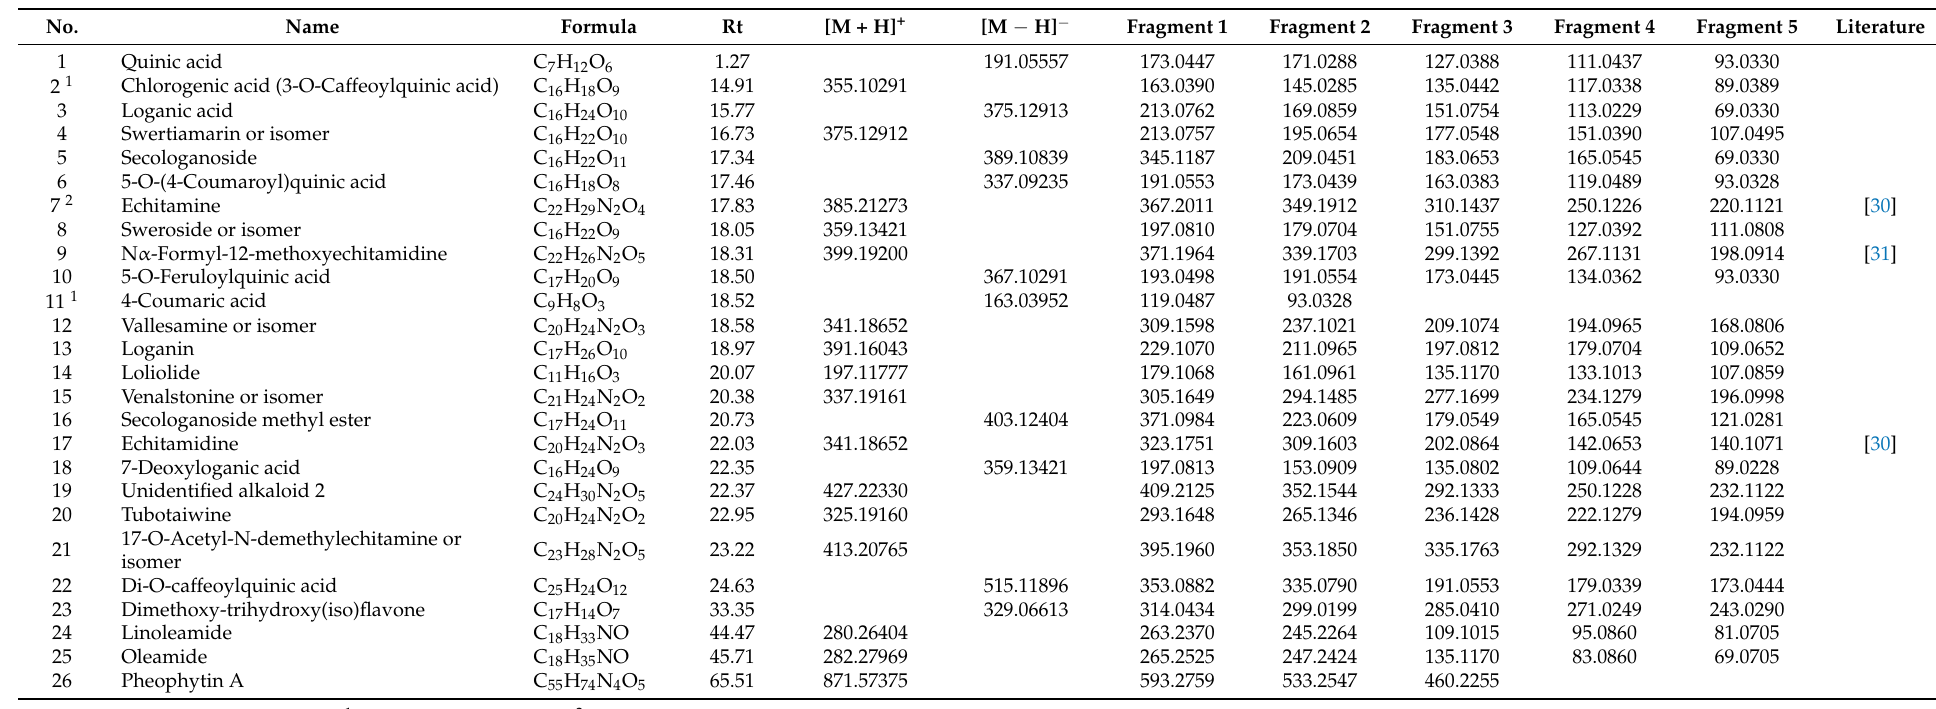
Table 6. Chemical characterization of stem bark—MAC-EA (not